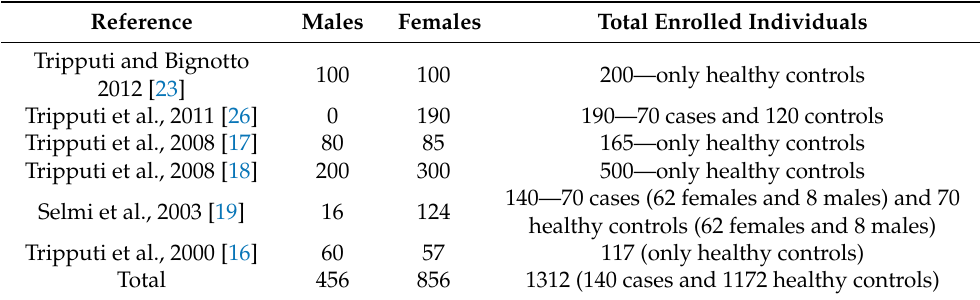
Table 1. Description of enrolled individuals from the six included studies (SD = standard deviation).